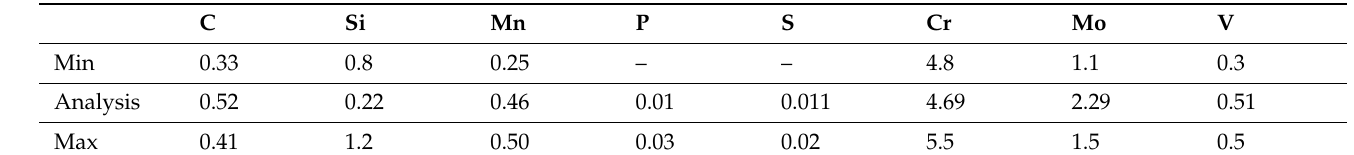
Table 1. Chemical composition (% by mass) of the tool material in relation to the EN ISO 4957: 2018 standard.